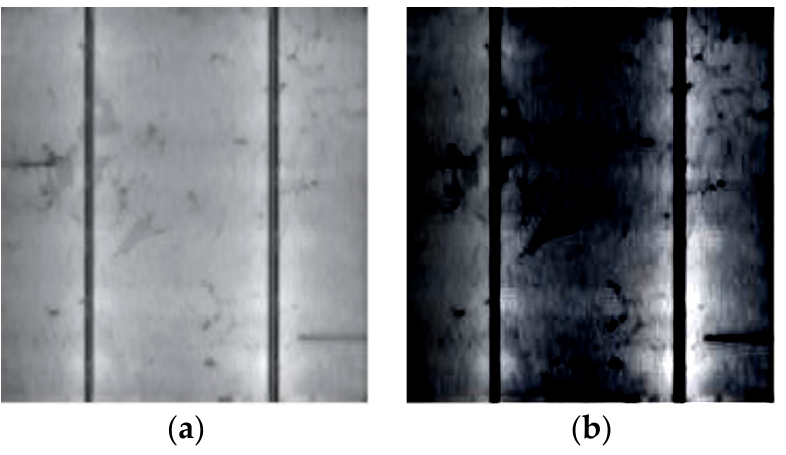
Figure 8. EL image of an examined solar cell sample: ( a ) before the PID test; ( b ) after the PID test with a duration of 96 h [61].